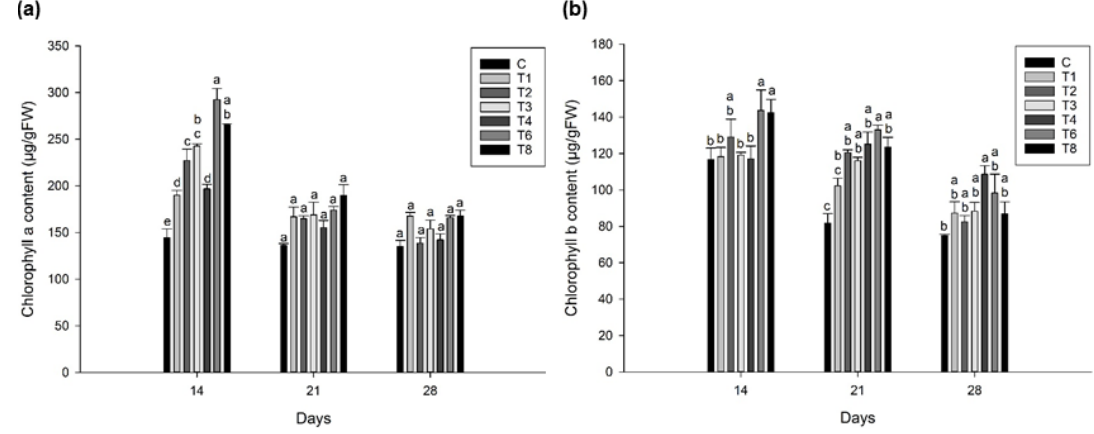
Figure 5. Effect of pretreatment of ANE and HA on the chlorophyll content of leaves of spinach stored after harvest. The effect of different concentrations of ANE, HA, and ANE + HA on the ( a ) chlorophyll a and ( b ) chlorophyll b contents of leaves of spinach stored for 14, 21, and 28 days at 0–4 °C in the dark with RH ≥ 95%. Different combinations of ANE and HA used for preharvest treatment were as follows: C (control), T1 (0.1% ANE), T2 (0.25% ANE), T3 (0.2% HA), T4 (0.4% HA), T6 (0.1% ANE + 0.4% HA), and T8 (0.25% ANE + 0.2% HA). Each experiment was performed in triplicate, and each experimental unit had six plants. The average of the eighteen values were presented as mean ± SE and means represented by same letters were not significantly different at p ≤ 0.05.